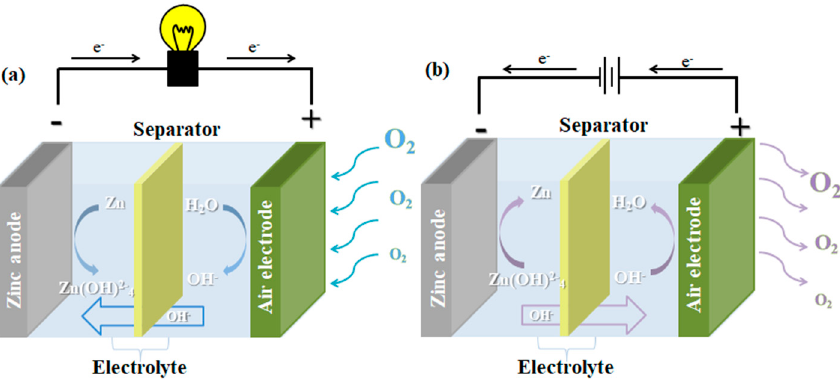
Figure 2. Schematic diagram of the working principle of Zn–air battery ( a ) discharge and ( b ) charge.